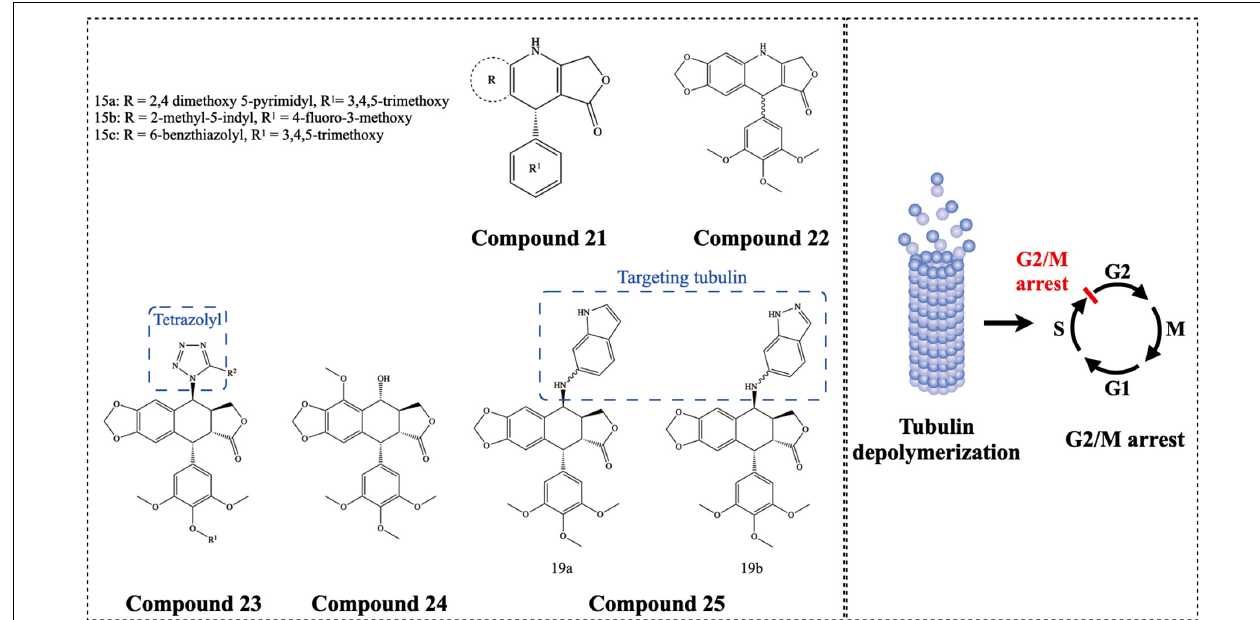
FIGURE 7 | Chemical structures and therapeutic highlights of PTOX derivatives Compound 21–25.